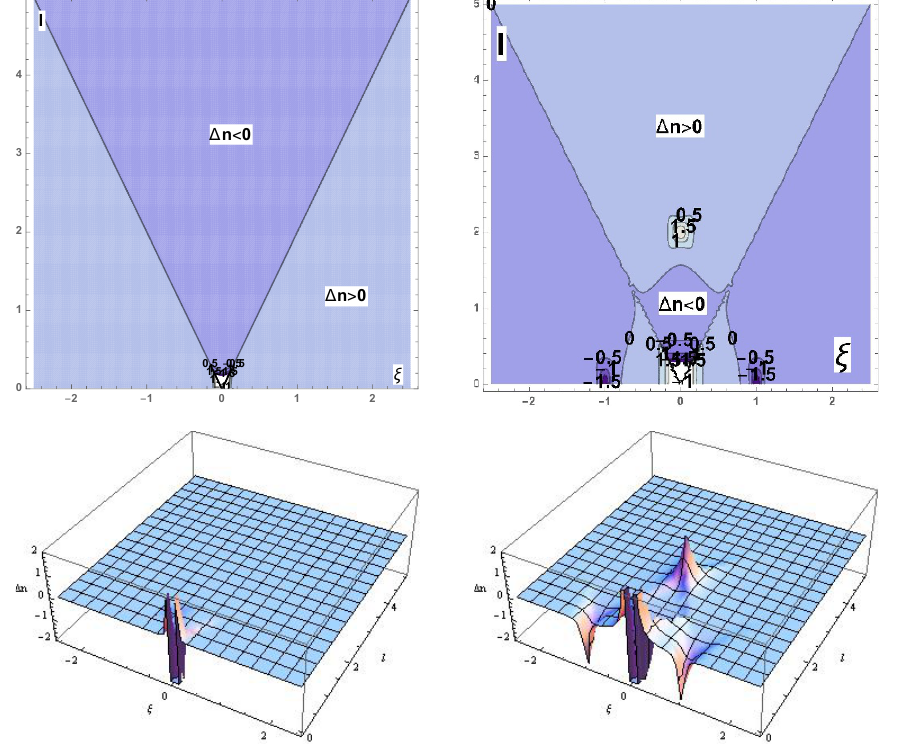
Figure 8 . The plots of the entanglement density (cid:1) n ( (cid:24); l; t ) for (cid:11) = 0 : 1 at t = 0 (left two graphs) and t = 1 (right two graphs). The upper and lower graphs are the contour and 3D plots. The horizontal and depth coordinate corresponds to (cid:24) and l ,